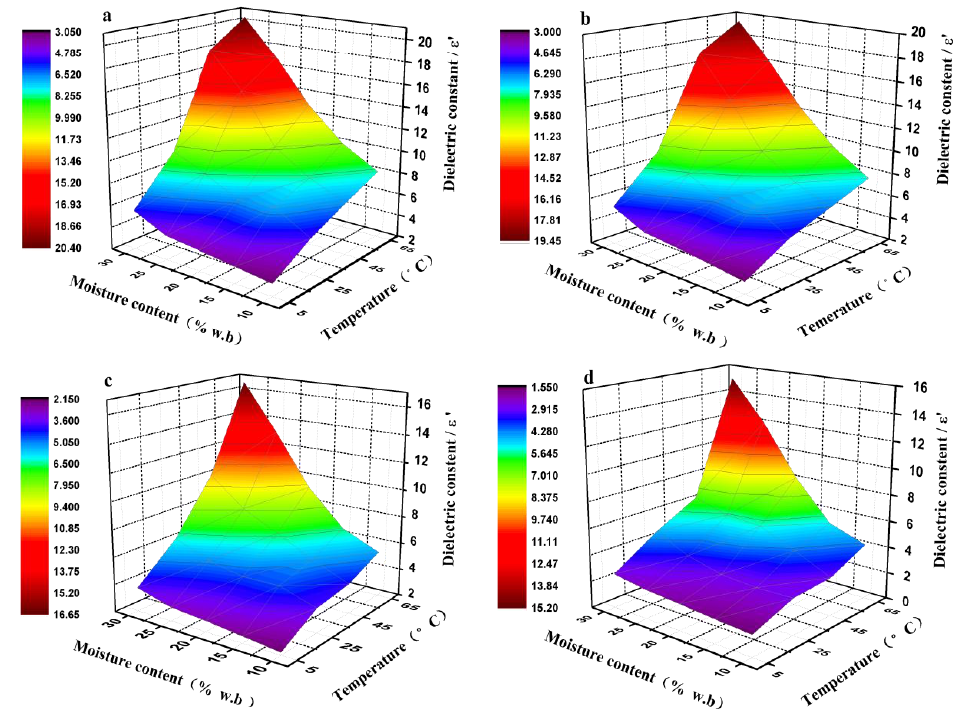
Figure 2. Three-dimensional representation of the dielectric constants of the pecan kernel as functions of the moisture content and temperature at frequencies of ( a ) 27, ( b ) 40, ( c ) 915, and ( d ) 2450 MHz.